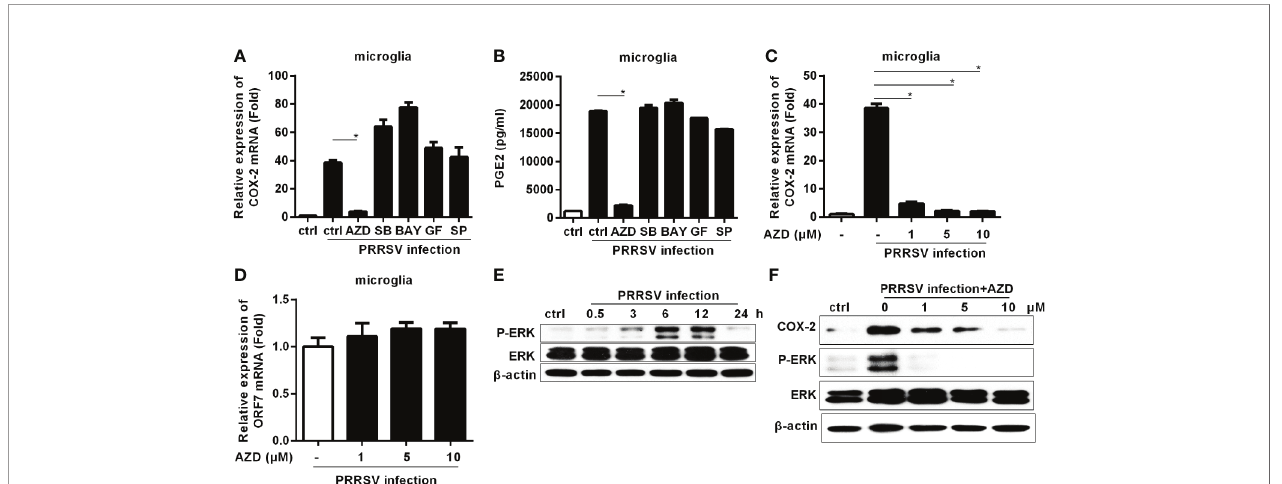
FIGURE 2 | Highly speci fi c MEK1 inhibitor impaired HP-PRRSV-induced COX-2 and PGE2 production in microglia. (A, B) Microglia were pretreated with DMSO control or inhibitors of MEK1 (AZD6244 [AZD]), p38MAPK (SB203580 [SB]), NF- k B (BAY11-7082 [BAY]), PKC (GF109203X [GF]), and JNK MAPK (SP600125 [SP]) for 1 hour, and then cells were mock infected or infected with HP-PRRSV strain HV (MOI, 0.1). At 6 hours later, cells were harvested for COX-2 mRNA analysis by real-time PCR (A) , and cell culture supernatants were harvested for testing PGE2 production by ELISA (B) . (C, D) Microglia were pretreated with DMSO or AZD at the indicated concentrations for 1 hour, and then mock infected or infected with HP-PRRSV strain HV at an MOI of 0.1. At 6 hours post-infection, cells were harvested for COX-2 (C) and ORF7 (D) analysis using real-time PCR. (E) Microglia were inoculated with HP-PRRSV strain HV (MOI, 0.1), and cells were harvested at 0.5, 3, 6, 12, and 24 hours post-infection. ERK1/2 and p-ERK1/2 were determined by immunoblotting with b -actin as a reference control. (F) Microglia were pretreated with DMSO or AZD at the indicated concentrations for 1 hour, and then mock infected or infected with HP-PRRSV strain HV (MOI, 0.1). At 12 hours post- infection, COX-2, p-ERK1/2 and ERK1/2 were examined by Western-blot with b -actin as a reference control. Data are representative of three independent experiments (mean ± SEM). Statistical analysis was performed by Student ’ s t -test. *, P < 0.05